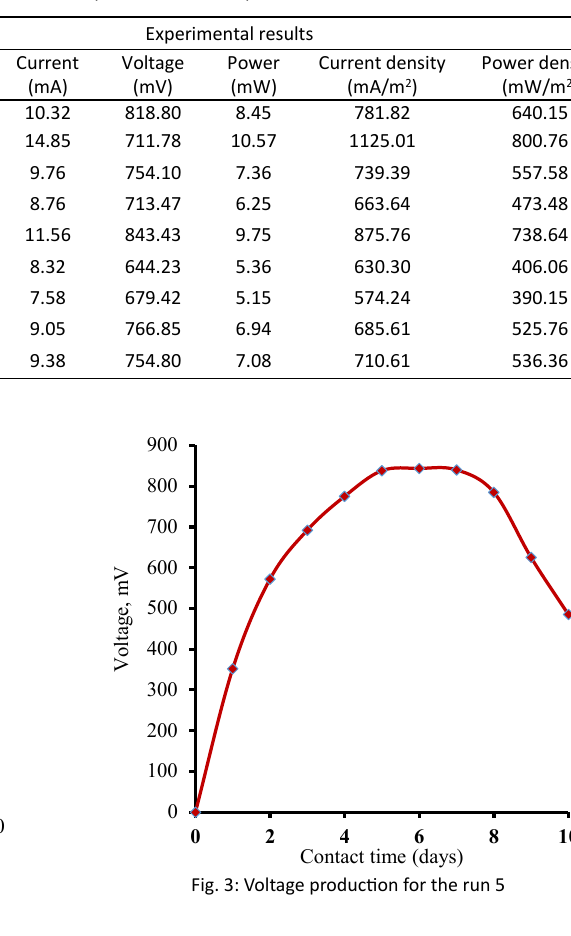
Table 4: L 9 orthogonal designs, levels of three parameters and experimental results Table 4: L orthogonal designs, levels of three parameters and experimental results 9